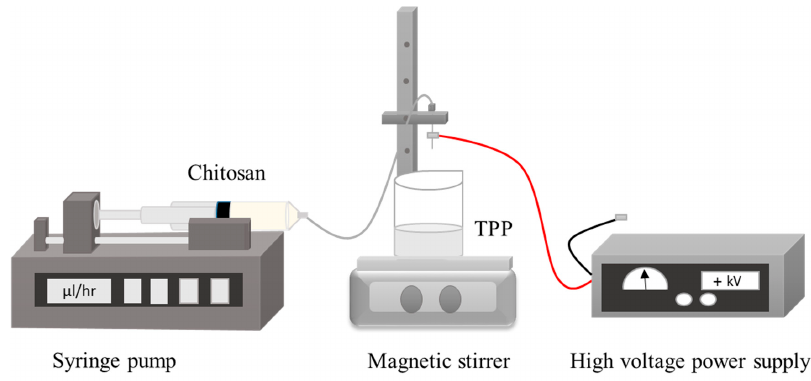
Figure 8. Schematic diagram of chitosan nanoparticles prepared via electrospray technique.